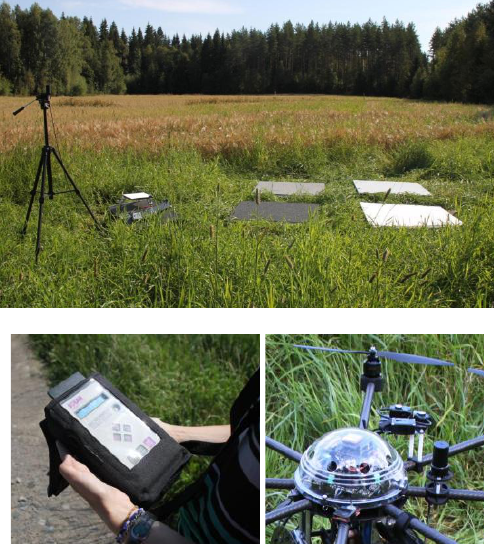
Figure 4. Measurement of illumination conditions using ASD spectrometer, Microtops sunphotometer and wideband irradiance sensor in the